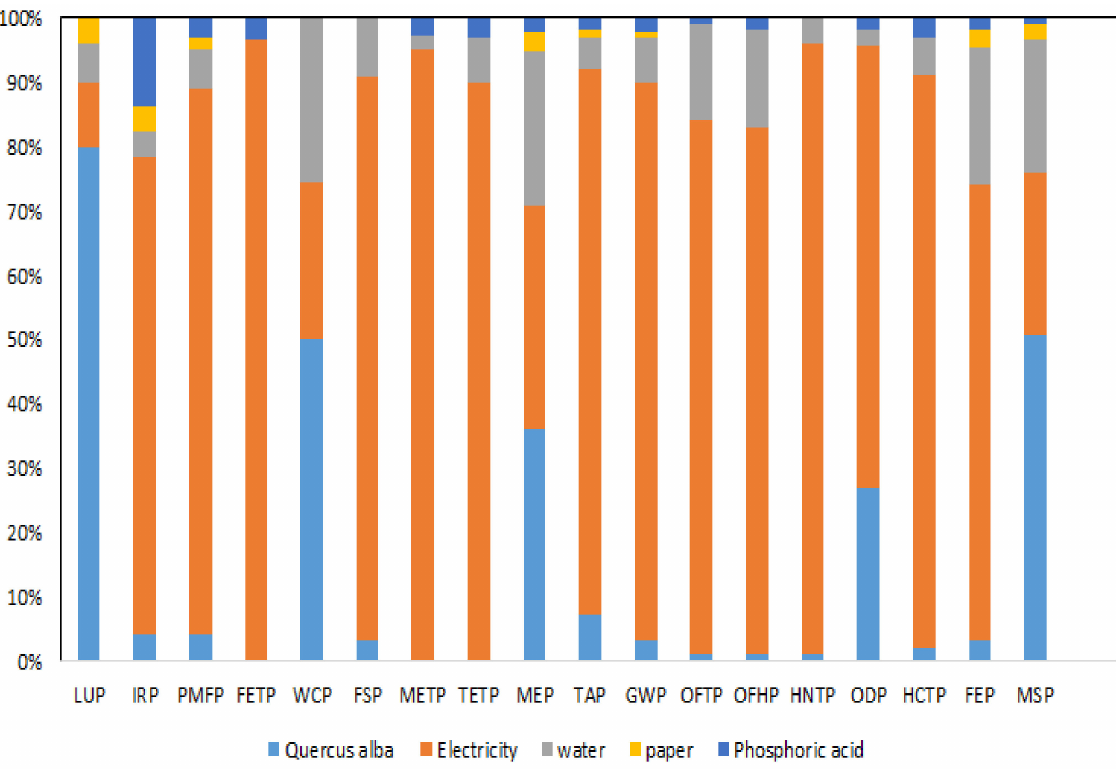
Figure 8. ReCiPe Midpoint (H) characterized percentage contribution of the AC production from waste leaves of Quercus alba (FU: 1